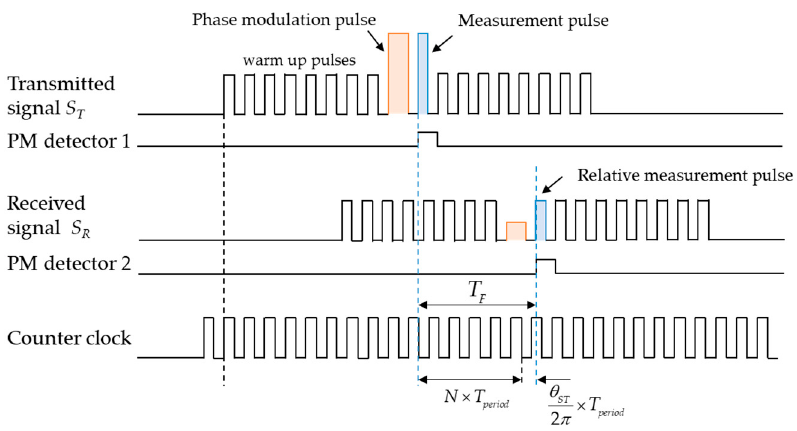
Figure 19. Examples of transmitted and received signals and ToF acquisition method.